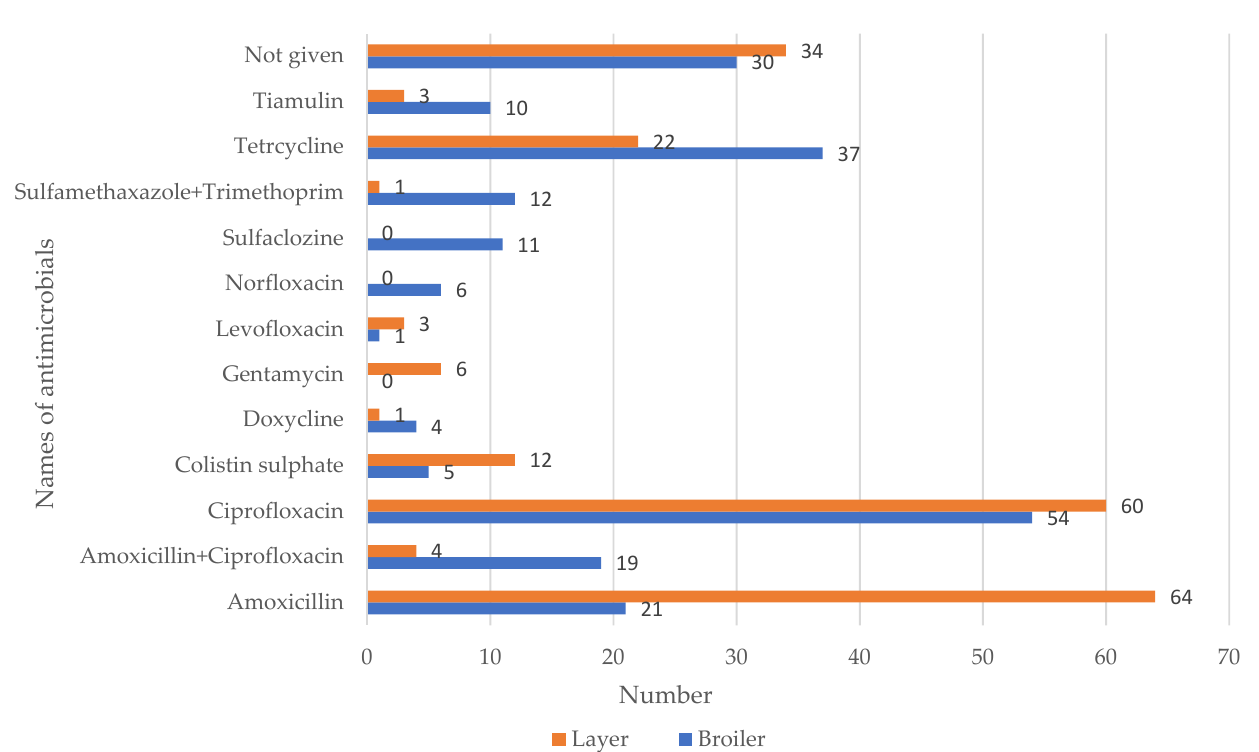
Figure 3. Use of antimicrobials on poultry farms against different diseases (disaggregated by the type of farm).